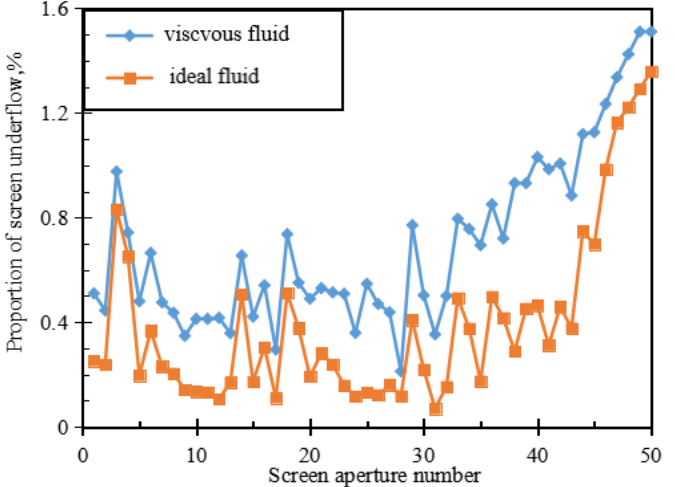
Figure 6. Velocity vector with multi-apertures for ( a ) viscous and ( b ) ideal fluid with inlet velocity 1 m/s.